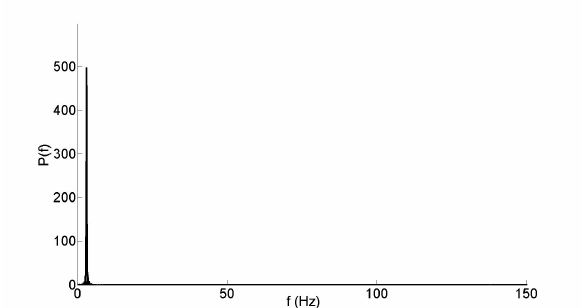
Figure 7. Power spectral density of thin plate centroid trajectory LDS measurement